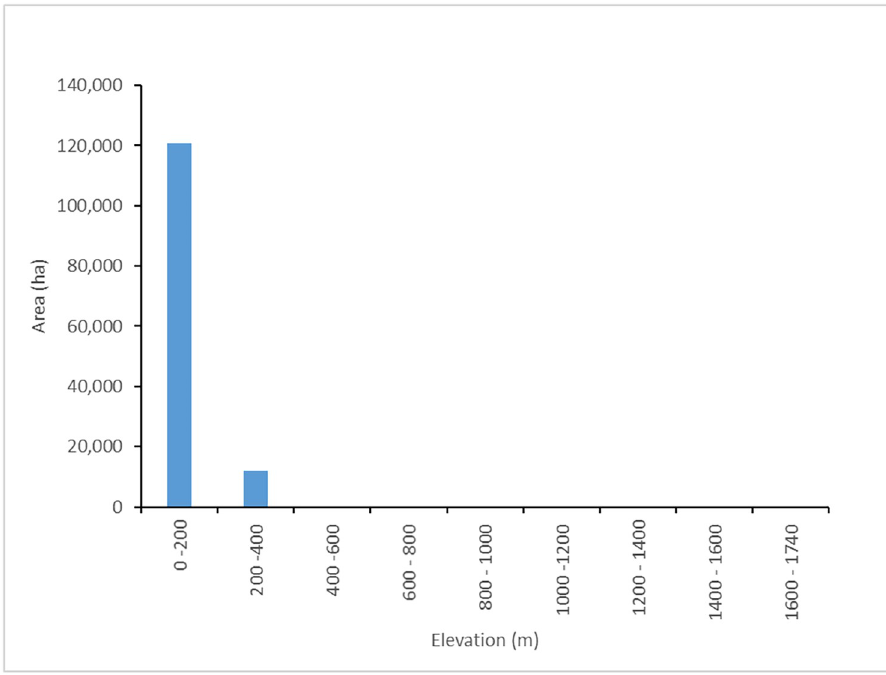
Fig 3. Vertical distribution of oil palm